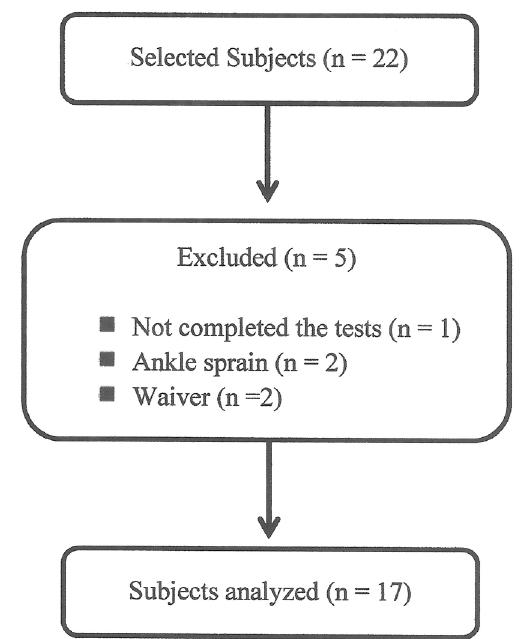
Figure 1. Research